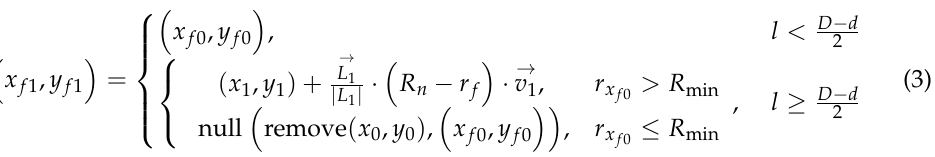
Figure 17. Approximate calculation of curvature radius for laying fiber track point.